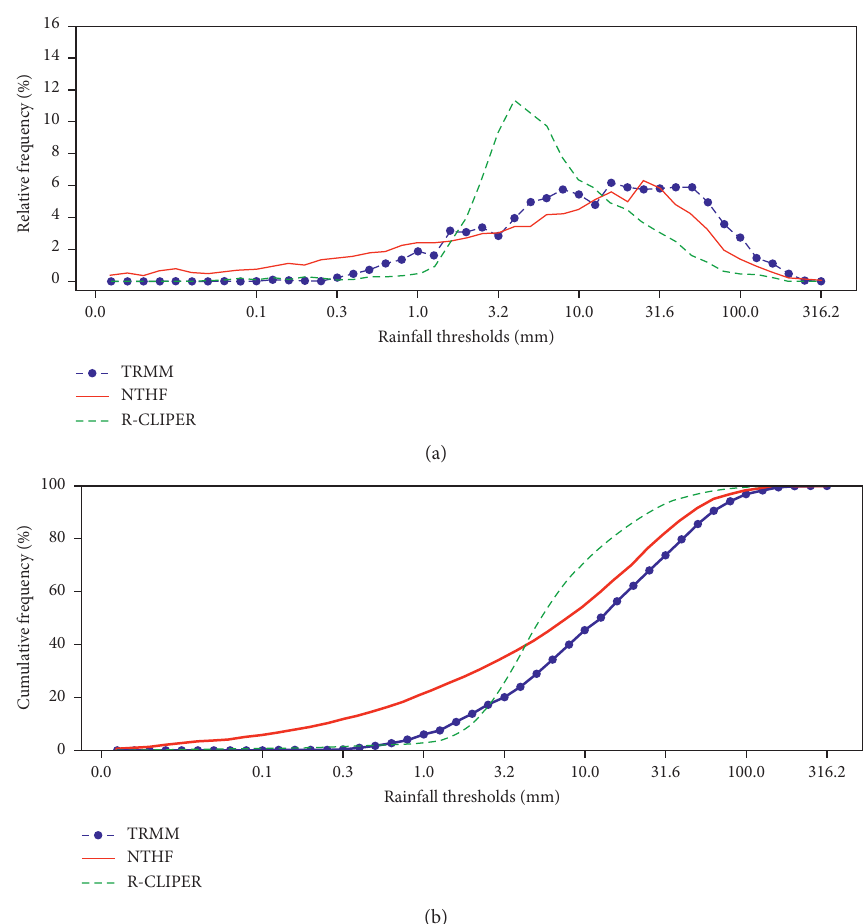
Figure 11: Frequency distribution of rain flux in first 24h of forecast. (a) Probability distribution function of observed (blue line) frequency of rainfall above a specified threshold, as well as that of NTHF (red line) and R-CLIPER (green line). (b) Cumulative distribution function of observed and predicted data, calculated from frequency distribution